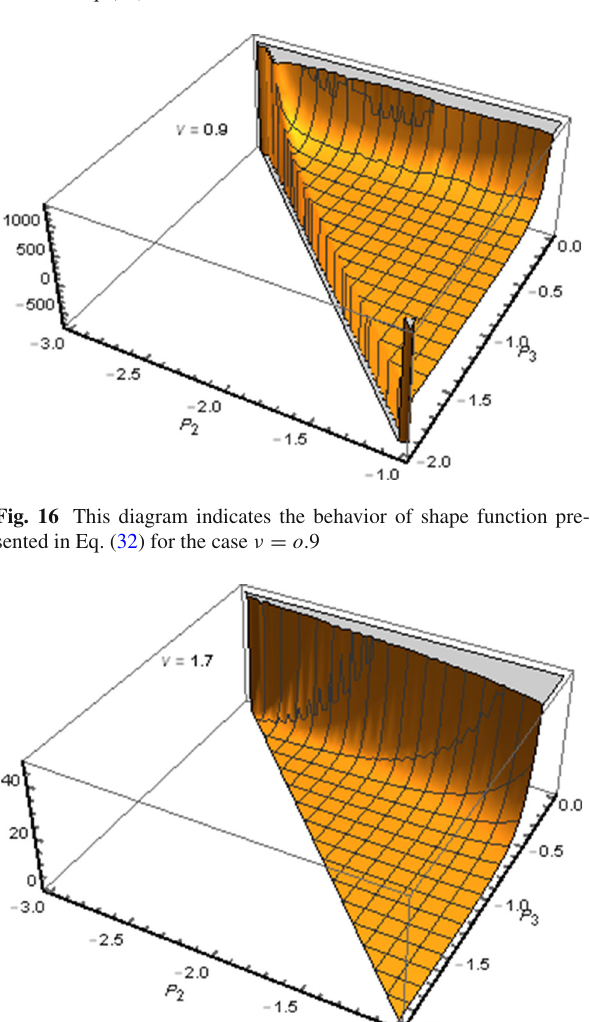
Fig. 15 This diagram expresses the behavior of shape function pre- sented in Eq. (32) for the case ν = o . 5